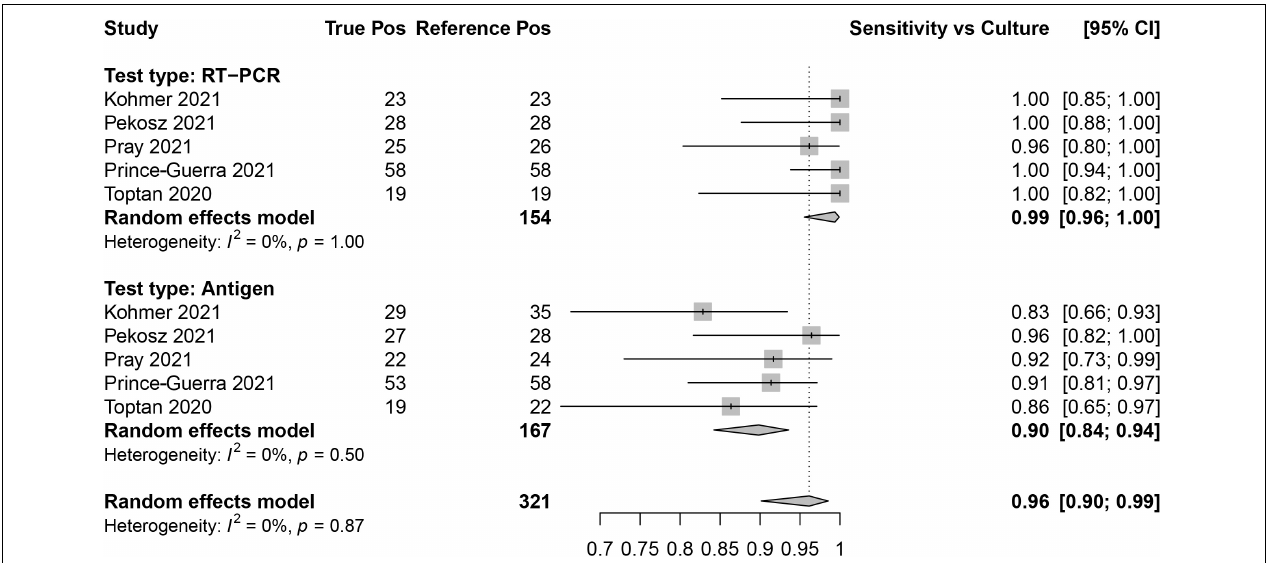
FIGURE 6 | Forest plots containing calculated sensitivity values for index [severe acute respiratory syndrome coronavirus-2 (SARS-CoV-2) antigen test and SARS-CoV-2 quantitative reverse transcription polymerase chain reaction (RT-qPCR assay)] testing compared to reference (SARS-CoV-2 viral culture)